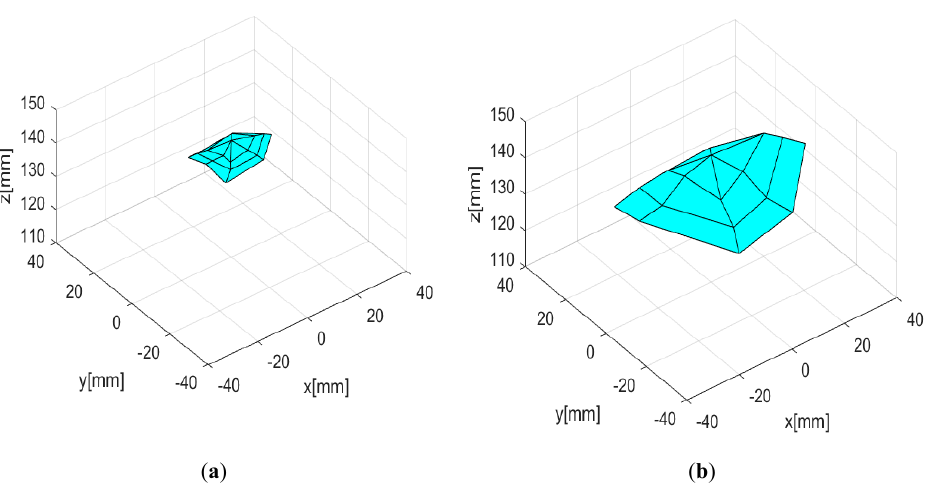
Figure 12. ( a ) 3D workspace of prototype B, and ( b ) 3D workspace of prototype B without antagonistic wires.